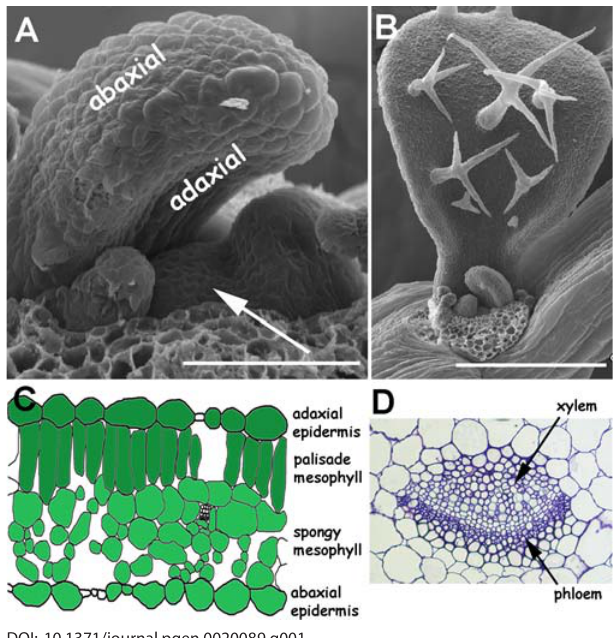
Figure 1. Leaves Arise on the Flanks of the Shoot Meristem (A) Vegetative apex of Arabidopsis . The adaxial side of the leaf is adjacent to the central shoot apical meristem, whereas the opposite, abaxial, side of the leaf is farther from the shoot meristem. Dorsoventrality is established early in development and is clearly evident in the leaf on the left, which arches over the meristem due to differential growth on each side of the leaf. Scale bar is 50 l m. (B) Developing vegetative leaf of Arabidopsis . Adaxial trichomes on the larger leaf are one marker distinguishing dorsoventrality. Scale bar is 250 l m. (C) Diagrammatic representation of a leaf cross section with adaxial and abaxial outer epidermal and inner mesophyll marked. (D) Cross section of leaf midvein with adaxial xylem and abaxial phloem cells marked.